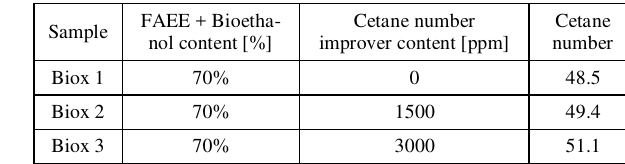
Table 5. Results of cetane number measurement as a function of cetane number improver